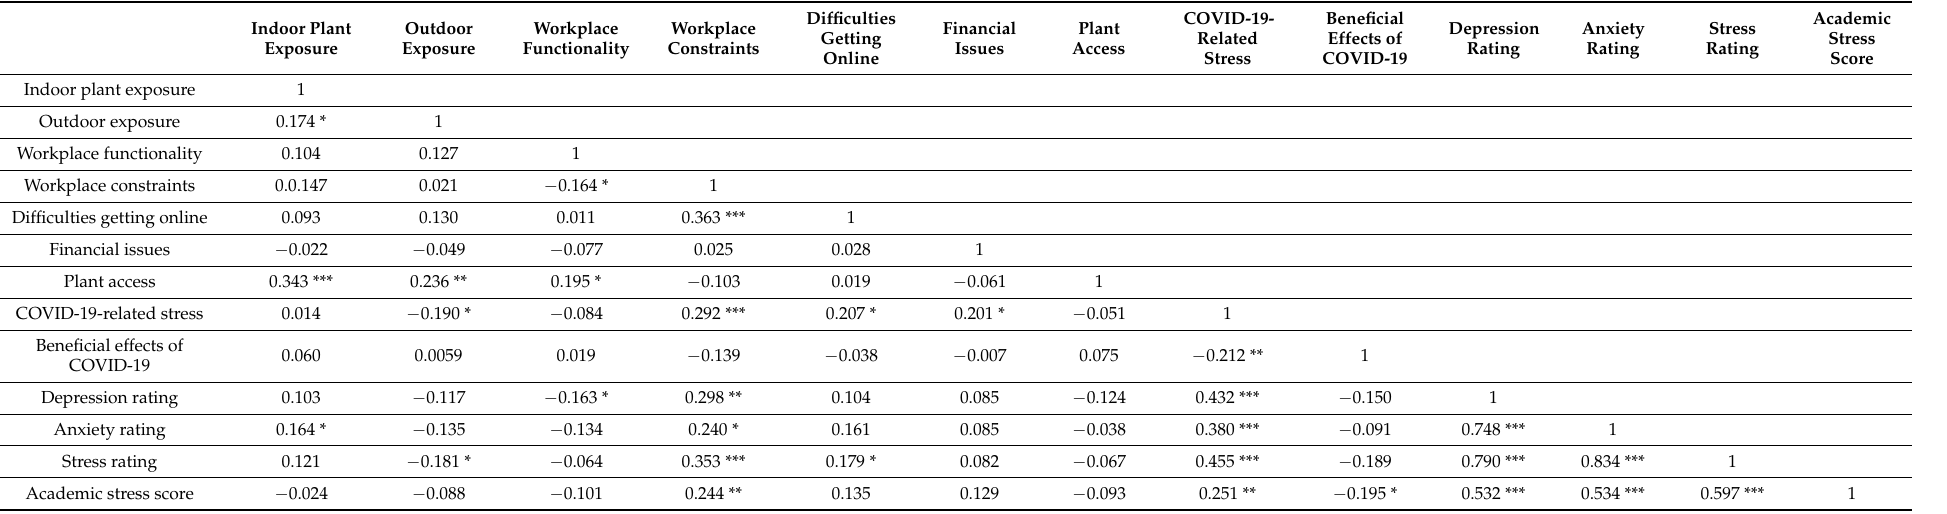
Table 5. Multivariate Correlation Analysis of DASA and survey categories for Spring/Summer. Spearman’s ρ correlation was performed to assess relationships between variables.